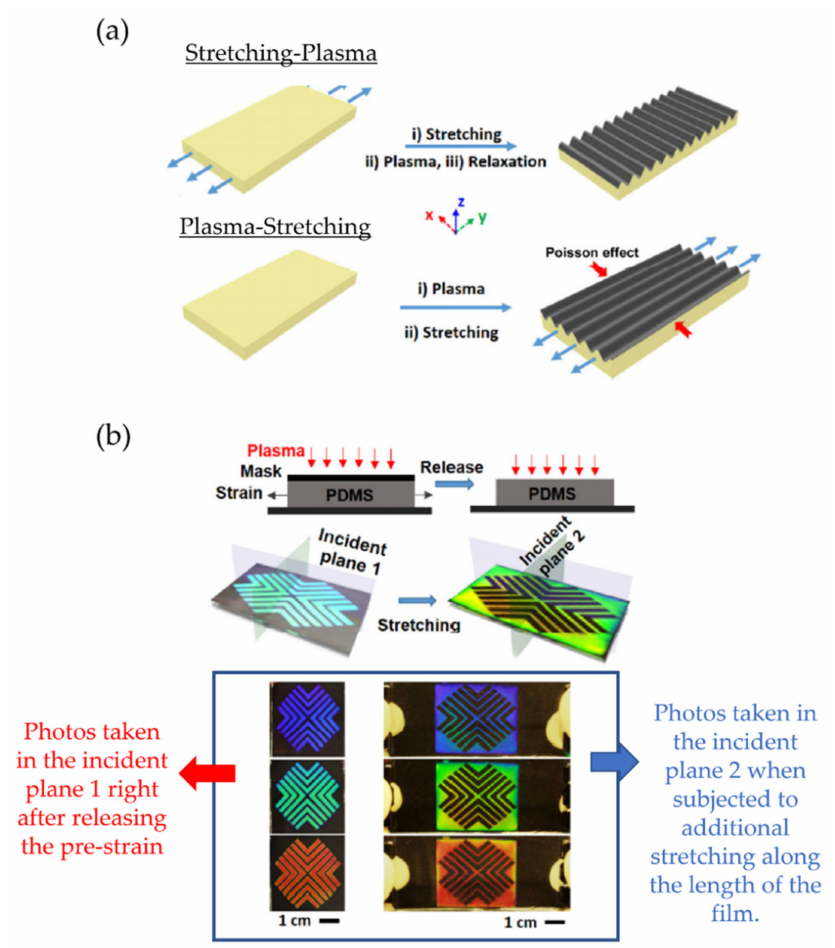
Figure 17. ( a ) Schematic illustration of the fabrication processes and ( b ) mechanochromic response and information encryption. Reproduced with permission from reference [72]. Copyright 2020, Springer